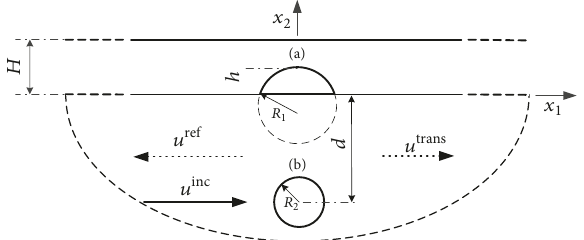
Figure 6: Schematic diagram for Love-wave scattering problem: (a) a cavity defect of arc surface on the bonding interface, with radius 𝑅 1 and height h ; (b) a circle defect in half-plane with radius depth d